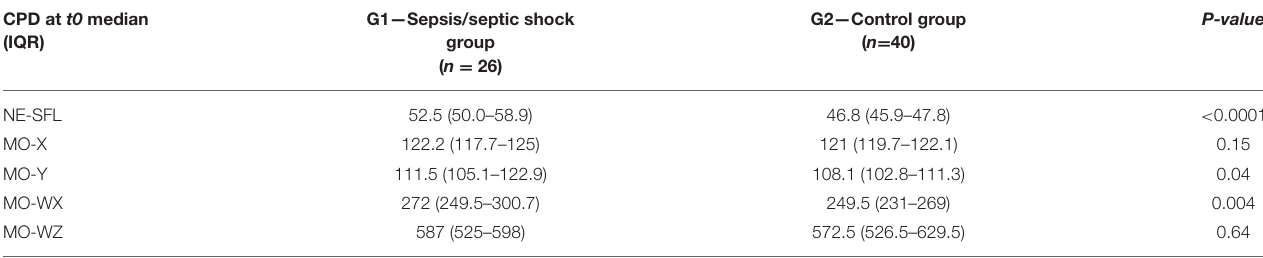
TABLE 2 | CPD values upon PICU admission (t0 ) in patients with sepsis/septic shock (G1 group) and controls